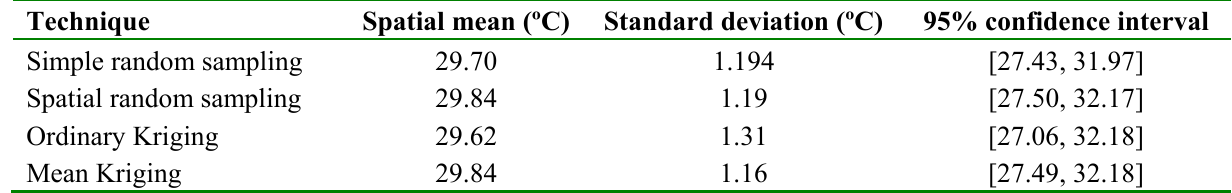
techniques (10% sampling proportion).